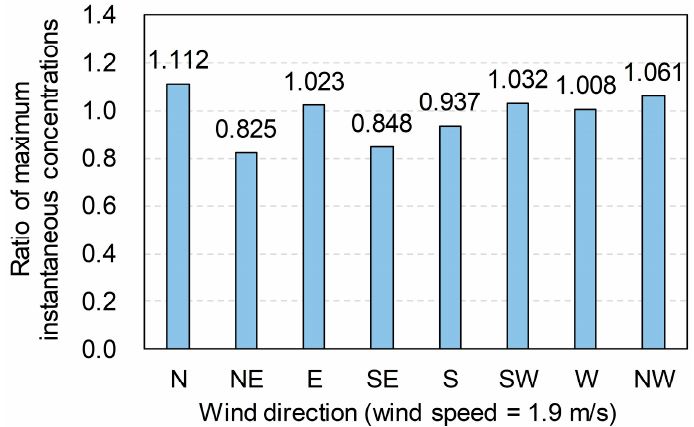
Figure 22. Ratios of the simulated maximum instantaneous concentrations near the fresh-air intakes in the final design phase to those in the transition design